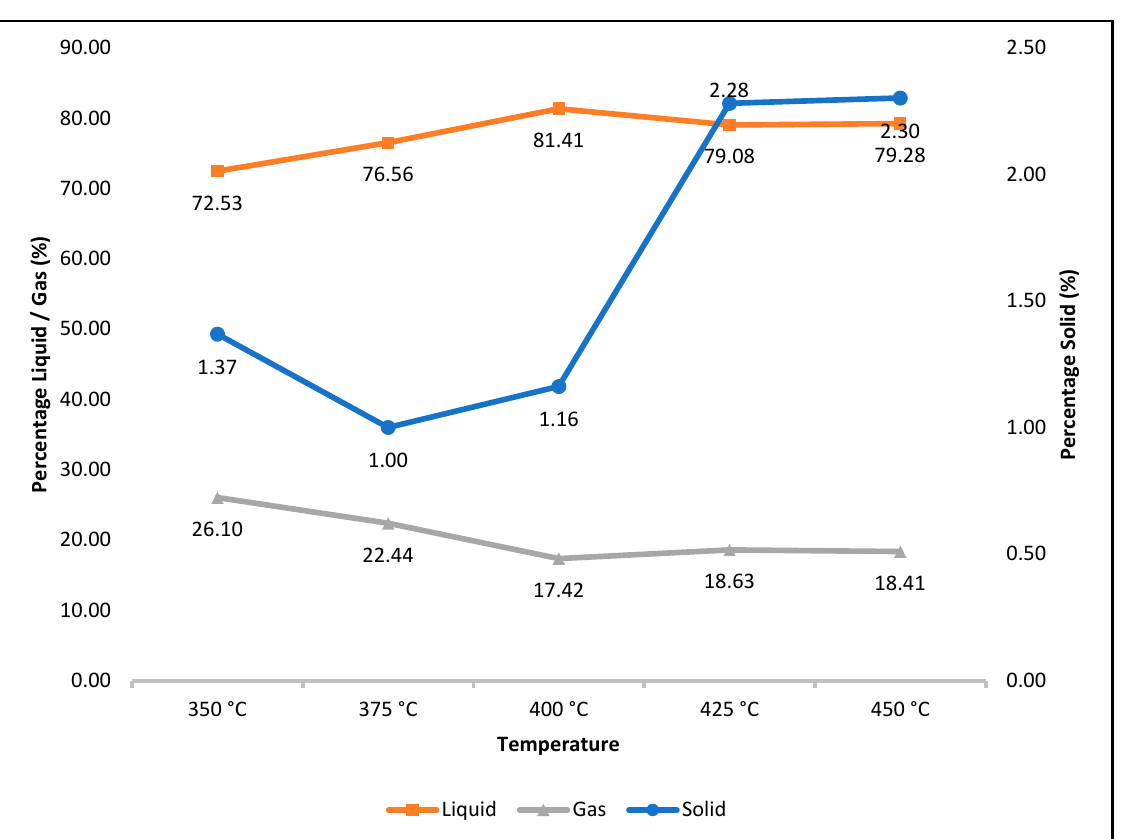
Figure 4. Distribution of liquid, solid, and gas mass fractions obtained from the pyrolysis of PS.